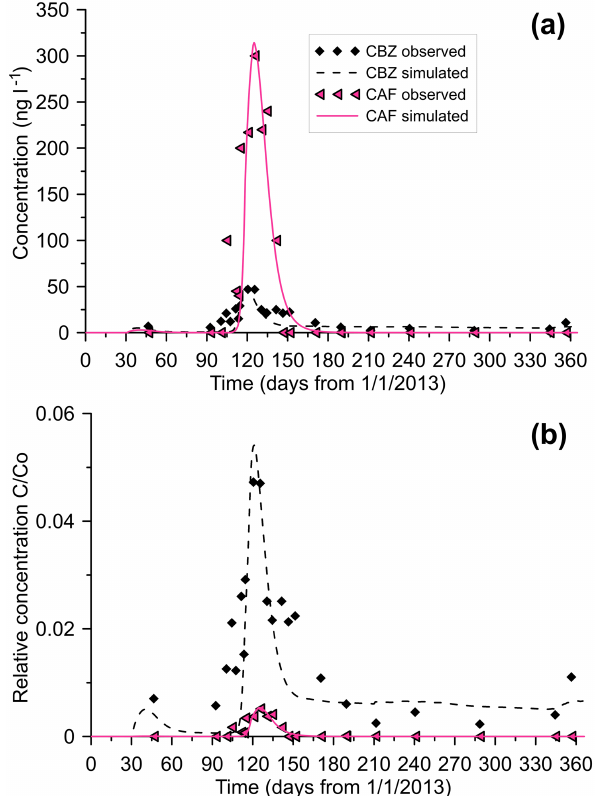
Figure 4. (a) Observed and simulated BTCs of CBZ and CAF in EK11; (b) relative concentration variations of CBZ and CAF in EK11 (CBZ data from Dvory et al.,